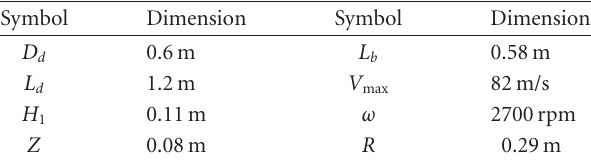
Table 1: Dimensions of tested deck and